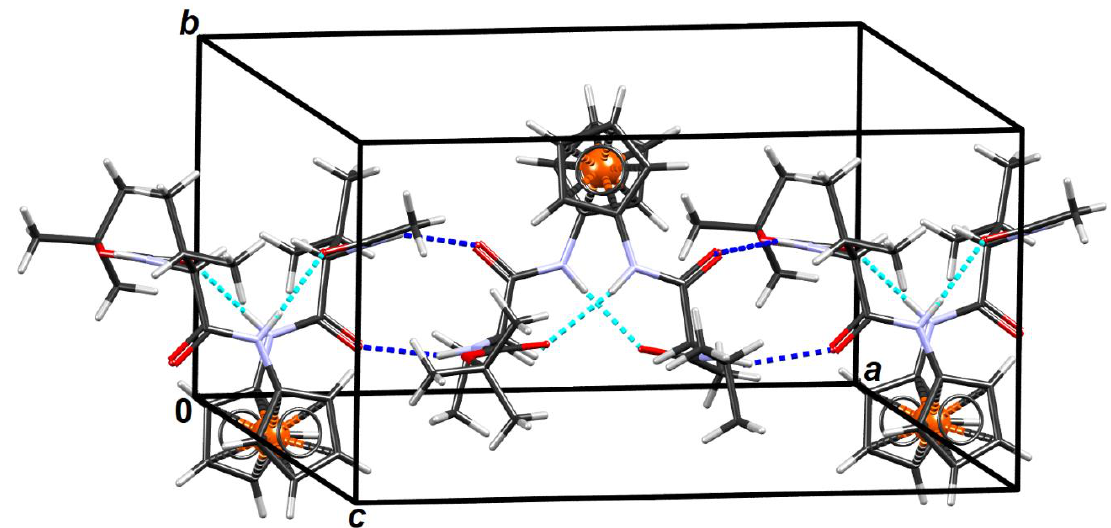
Figure 10. A hydrogen bonded chain parallel to [100] in crystal packing of L -Val peptide 33 . Intramolecular hydrogen bonds are shown as cyan and intermolecular as dark blue dashed lines.